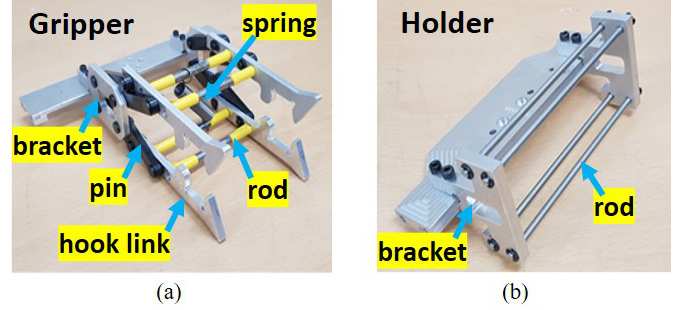
Figure 3. Hook-link module. ( a ) Gripper. ( b )